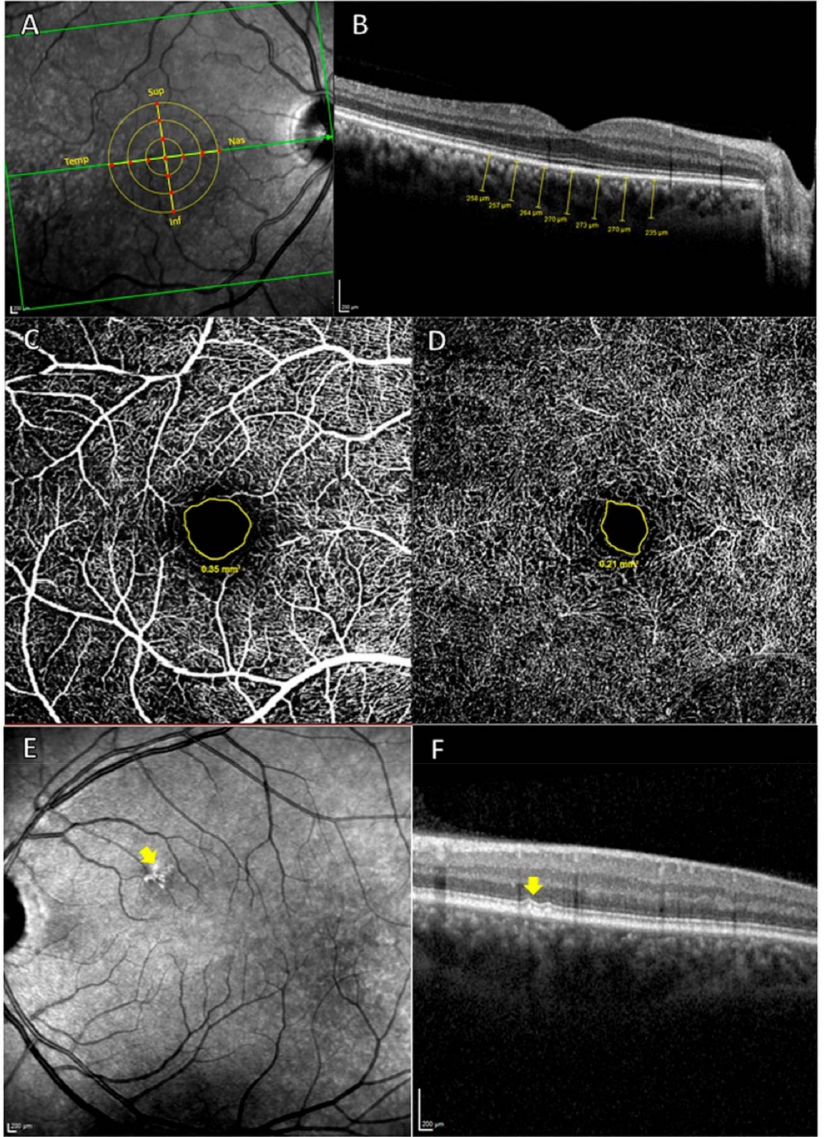
Figure 2. ( A , B ) measurement of the choroidal thickness. ( A ) Retinal zone analyzed. The 13 red points indicate where the choroidal thickness measurements were carried out. Sup: superior; Nas: Nasal; Inf: Inferior; Temp: Temporal. ( B ) Choroidal thickness measur measurements ( µ m). ( C , D ), measurement of FAZ. ( C ) OCTA of superficial vascular plexus, with the avascular area outlined in yellow. ( D ) OCTA of deep vascular plexus, with the avascular area outlined in yellow and, ( E ) and ( F ), hard drusen analysis by OCT. ( E ) The yellow arrow shows hyper-reflective shapes in the HRA fundus image. ( F ) Cross-Sectional OCT. The yellow arrow indicates hard drusen localized between the basal lamina of the RPE and the inner collagen layer of Bruch’s